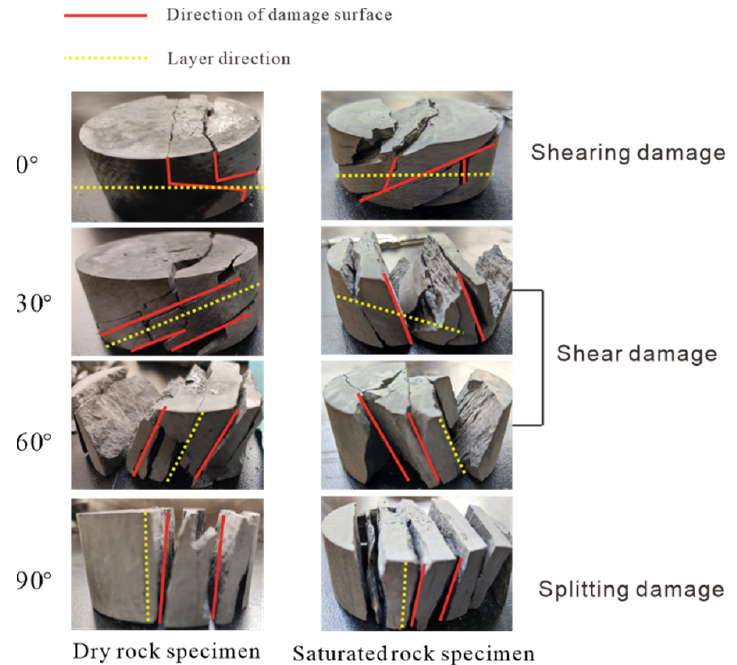
Figure 9. Destruction patterns.